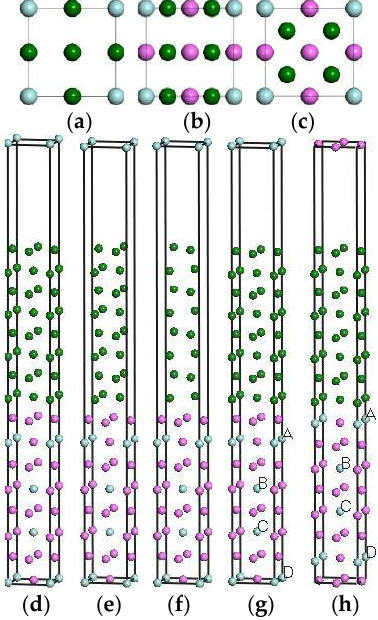
Figure 3. Interfacial stacking models paralleling to (001) plane. ( a ) top view of top-site model; ( b ) top view of bridge-site model; ( c ) top view of central-site model; ( d ) stereogram of top-site model; ( e ) stereogram of bridge-site model; ( f ) stereogram of central-site model; ( g ) Al/Al 3 TM(I-ter); ( h ) Al/Al 3 TM(D-ter).